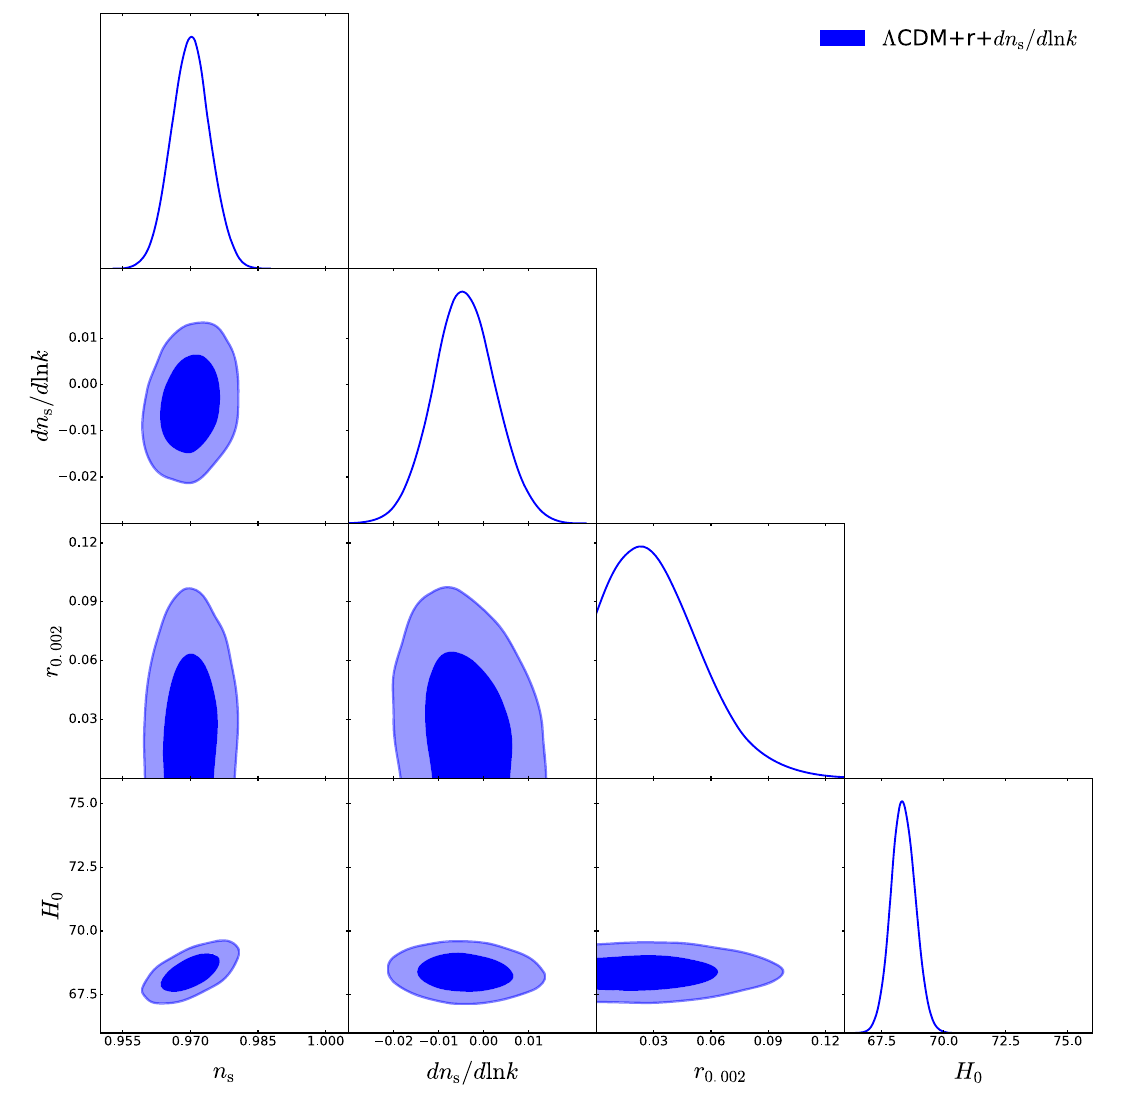
Fig. 4 One-dimensional marginalized distributions and two-dimensional contours (1 σ and 2 σ ) for parameters n s , d n s / d ln k , r 0 . 002 , and H 0 in the (cid:2) CDM + r + d n / d ln k model using the Planck + BK + BAO + H s